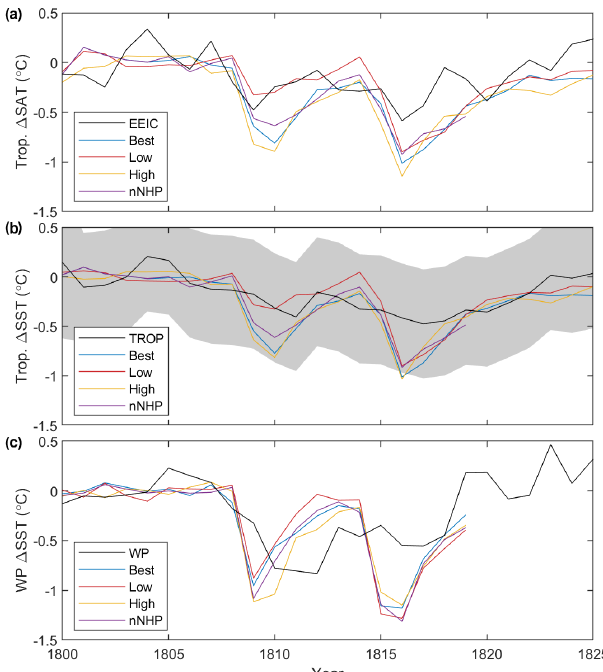
Figure 6. Comparison of tropical temperatures anomalies. Com- parison of the MPI-ESM simulations with (a) tropical and annual mean (30 ◦ N–30 ◦ S) surface air temperature from shipborne mea- surements of the English East India Company (EEIC; Brohan et al., 2012), (b) annual mean tropical sea surface temperature (SST) reconstruction (TROP; D’Arrigo et al., 2009) over the tropical Indo-Pacific (30 ◦ N–30 ◦ S, 34 ◦ E–70 ◦ W), and (c) seasonal mean (September–November) SST reconstruction (D’Arrigo et al., 2006) anomalies over the Indonesian warm pool (WP; 15 ◦ S–5 ◦ N, 110– 160 ◦ E). The black line represents the observed or reconstructed data in all panels, while the colored lines represent ensemble means of the respective model simulations. The grey shaded regions in (b) indicate the 95% confidence interval of the reconstruction. Anoma- lies are taken with respect to the years 1800 to